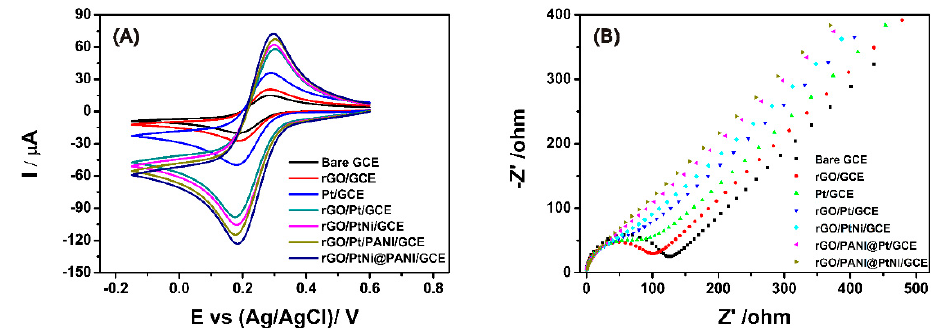
Figure 6. Cyclic voltammetry (CV) of bare GCE, rGO / GCE, Pt / GCE, rGO / Pt / GCE, rGO / PtNi / GCE, rGO / PANI@Pt / GCE and rGO / PANI@PtNi / GCE in 0.1 M KCl containing 5.0 mM Fe(CN) 63 − at the scan rate of 50 mV / s ( A ); electronic impedance spectroscopy (EIS) spectra obtained at bare GCE, rGO / GCE, Pt / GCE, rGO / Pt / GCE, rGO / PtNi / GCE, rGO / PANI@Pt / GCE and rGO / PANI@PtNi / GCE in 0.1 M KCl containing 5.0 mM Fe(CN) 63 − / 4 − ( B ). Table 1. The anodic peak current and the average electroactive surface area of PtNi on different electrodes. Electrode Anodic Peak Current (µA) Average Electroactive Surface Area * (cm 2 )